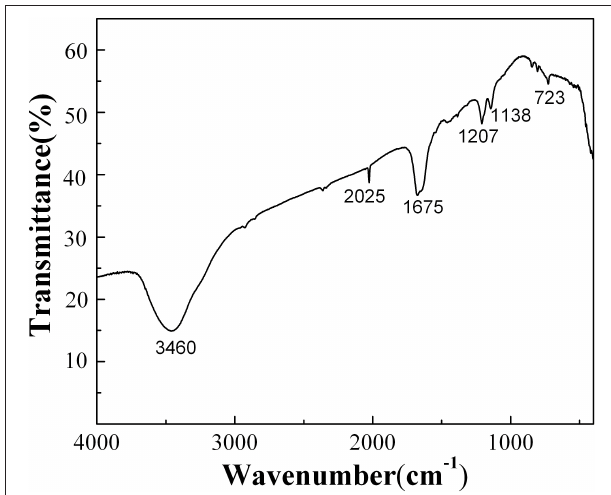
FIGURE 2 | FTIR spectrum of BaF 2 :Nd (3 mol%) nanopowders.